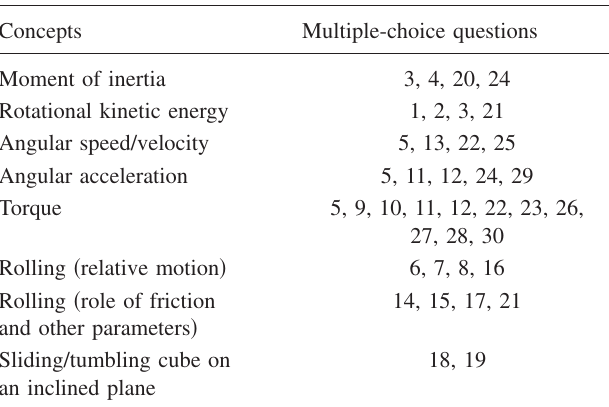
TABLE I. The different concepts covered and the questions in the multiple-choice test that addressed them. (cid:1) See Appendix B (cid:2) .